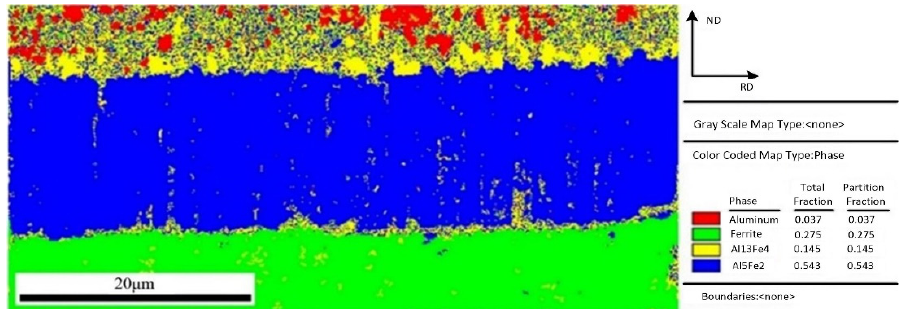
Figure 7. EBSD phase map of interface layer.